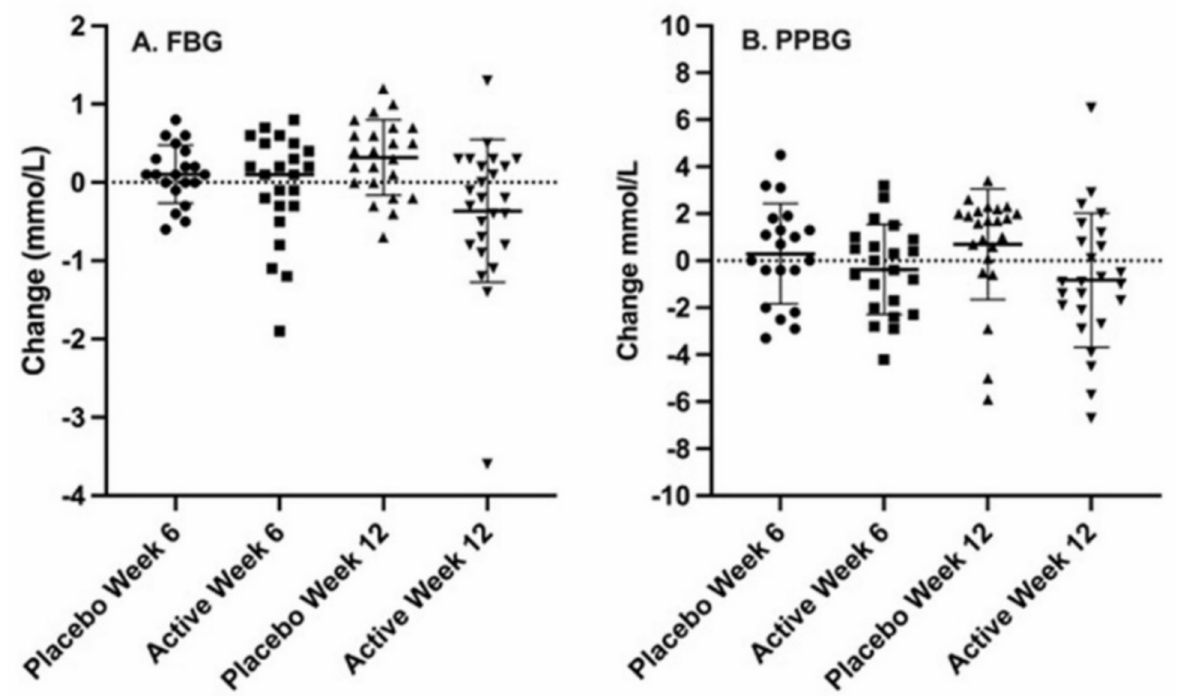
Figure 2. Change from baseline in fasting blood glucose levels (( A ) FBG) and 2 h post prandial